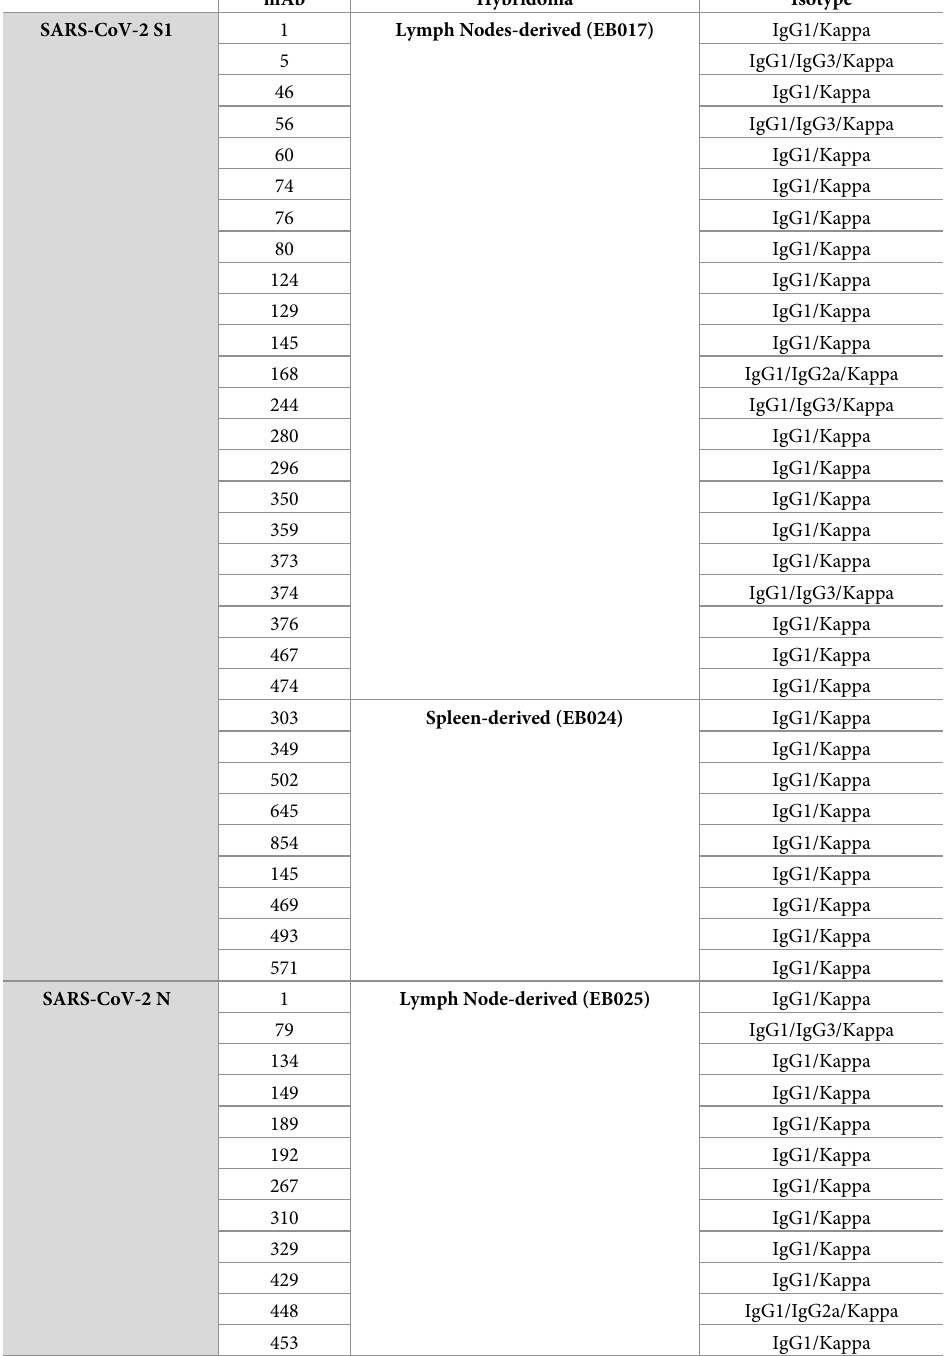
Table 1. mAbs that detect SARS-CoV-2 S1 or N proteins by ELISA and flow cytometry. mAb Hybridoma